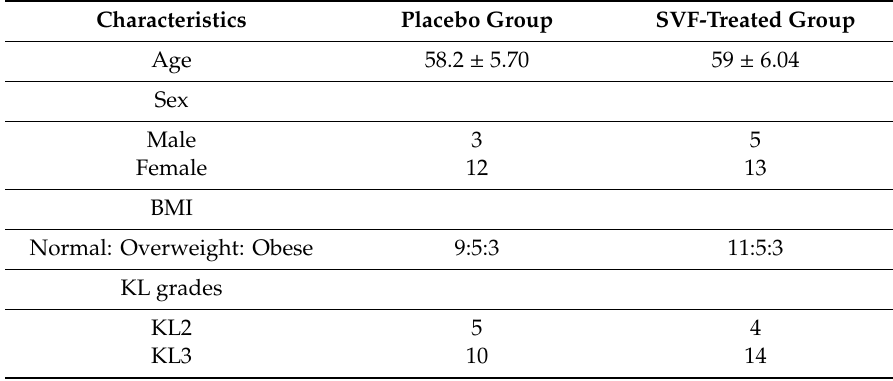
Table 1. Population characteristics of the patients. BMI: Body mass